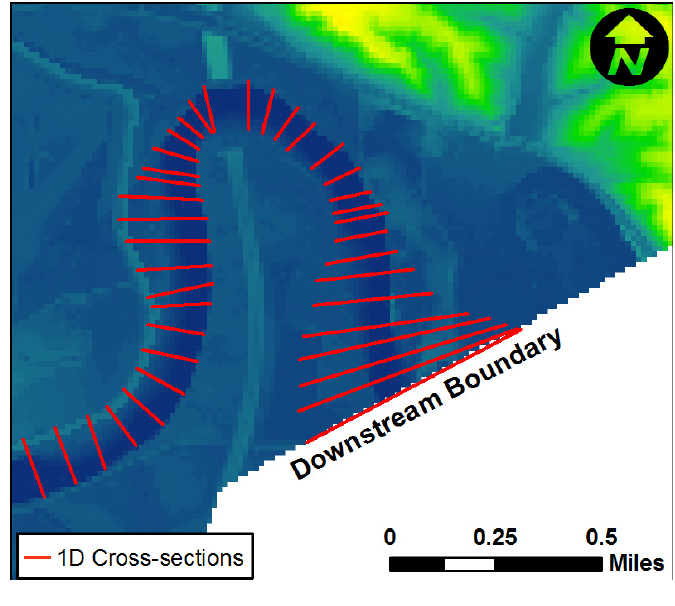
Figure 8. Example downstream boundary of coupled 1D/2D